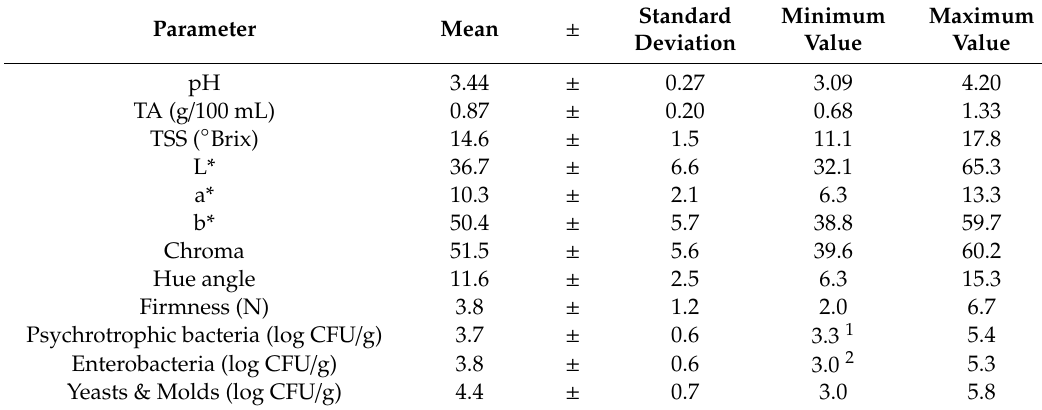
Table 3. Values and dispersion of physicochemical parameters and microbiological counts of minimally-processed pineapple